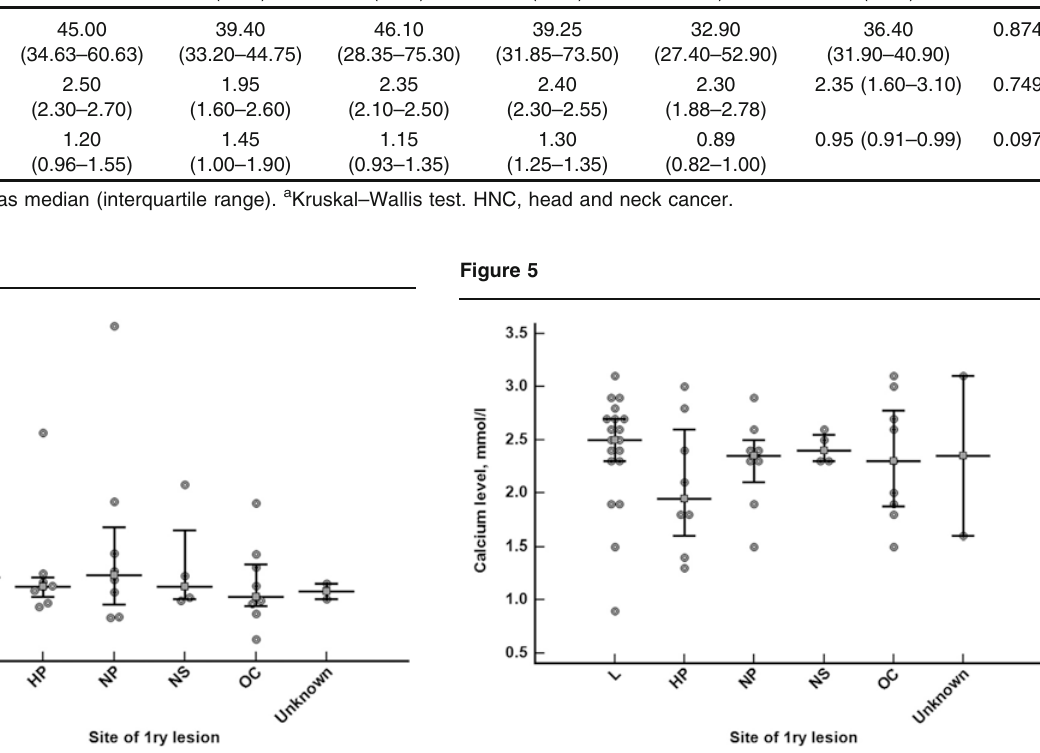
Calcium level by site of HNC. Circular markers represent individual observations. Squared marker with traversing horizontal line repre- sents the median (second quartile). Error bars represent the 25th and 75th percentiles (first and third quartiles, respectively). HNC, head and neck cancer; HP, hypopharyngeal; L, laryngeal; NP, nasopha- ryngeal; NS, nasal sinus; OC, oral